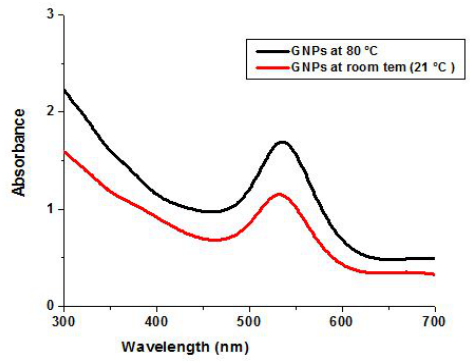
Figure 3. Effect of heat on GNPs.